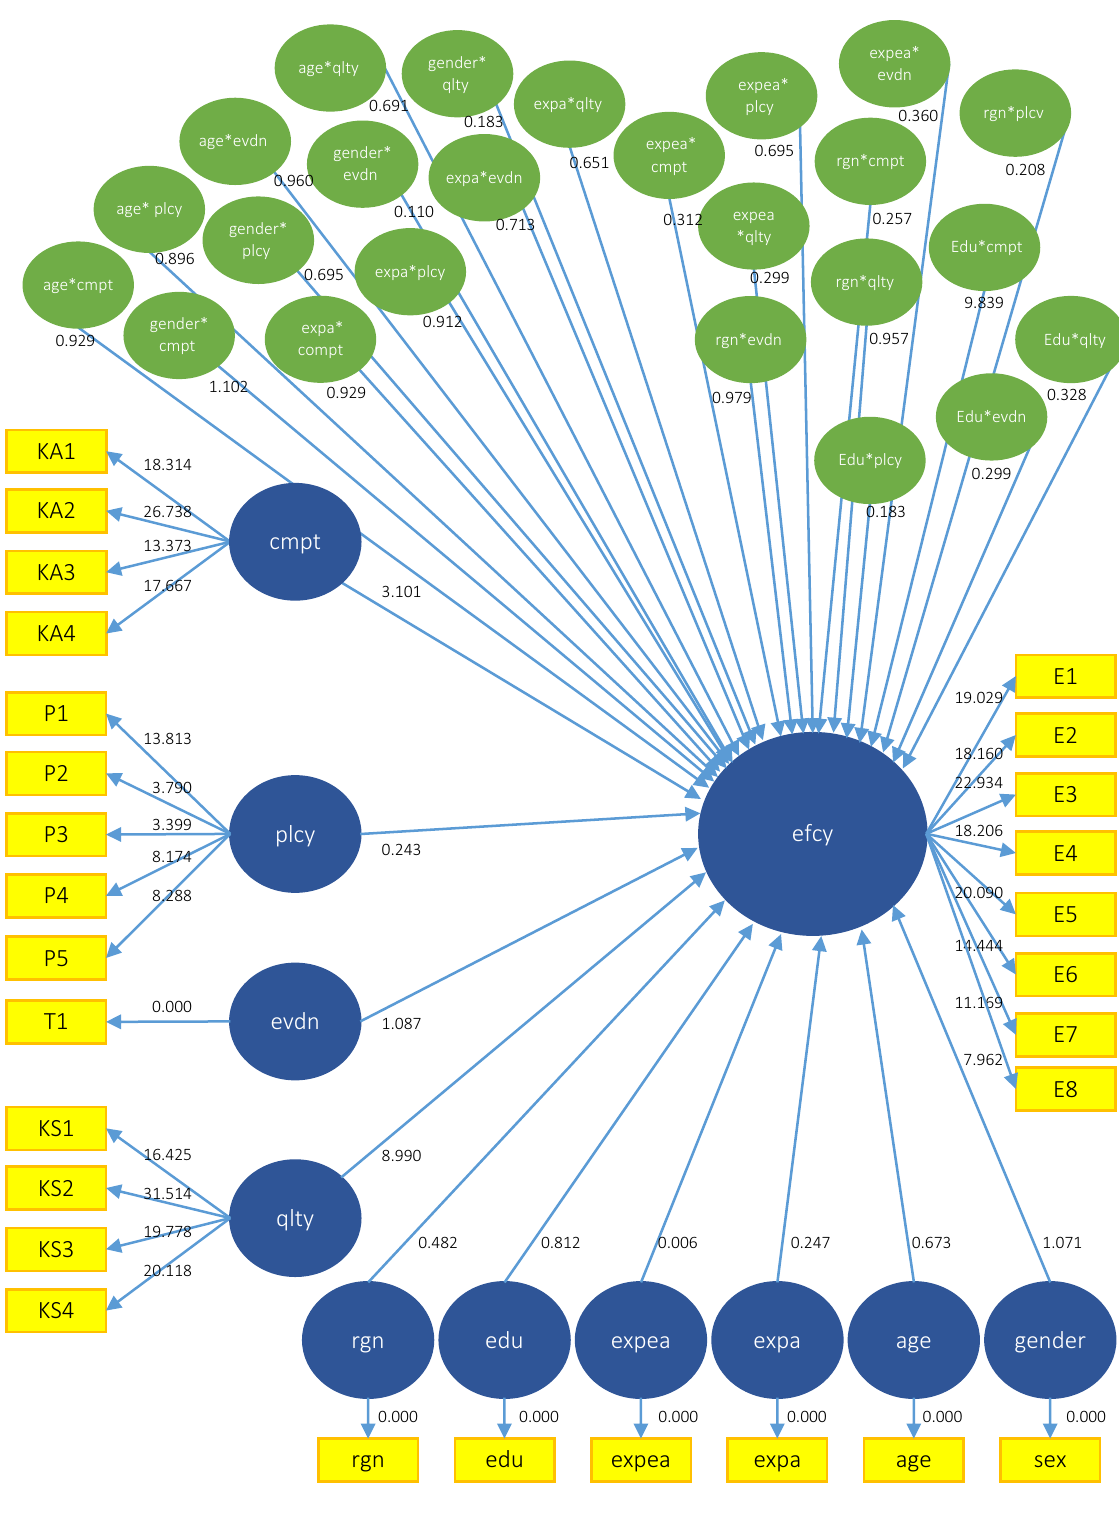
Figure 1. Result of research